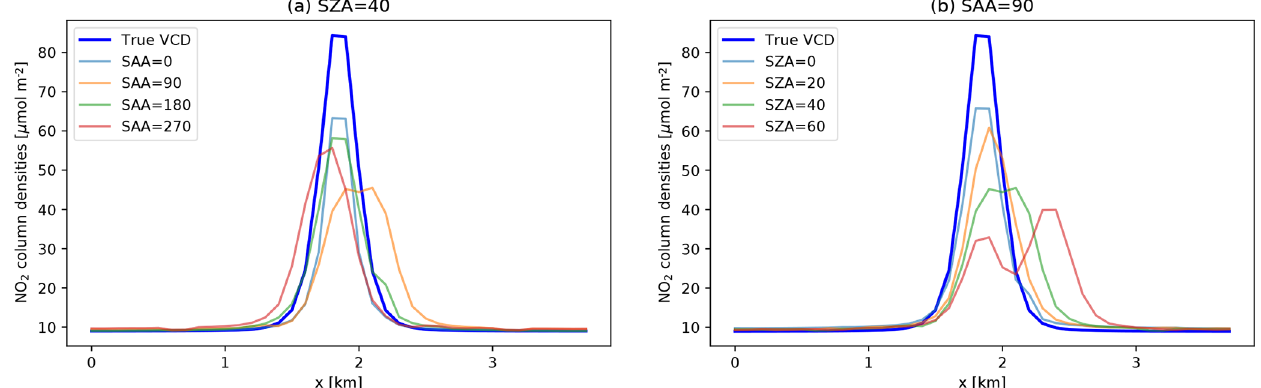
Figure 12. Plume VCD cross section at y = 1 . 6km (0.3km downstream of the plume) for (a) the sun at SZA = 40 ◦ with different SAAs and (b) for the sun in the west with different